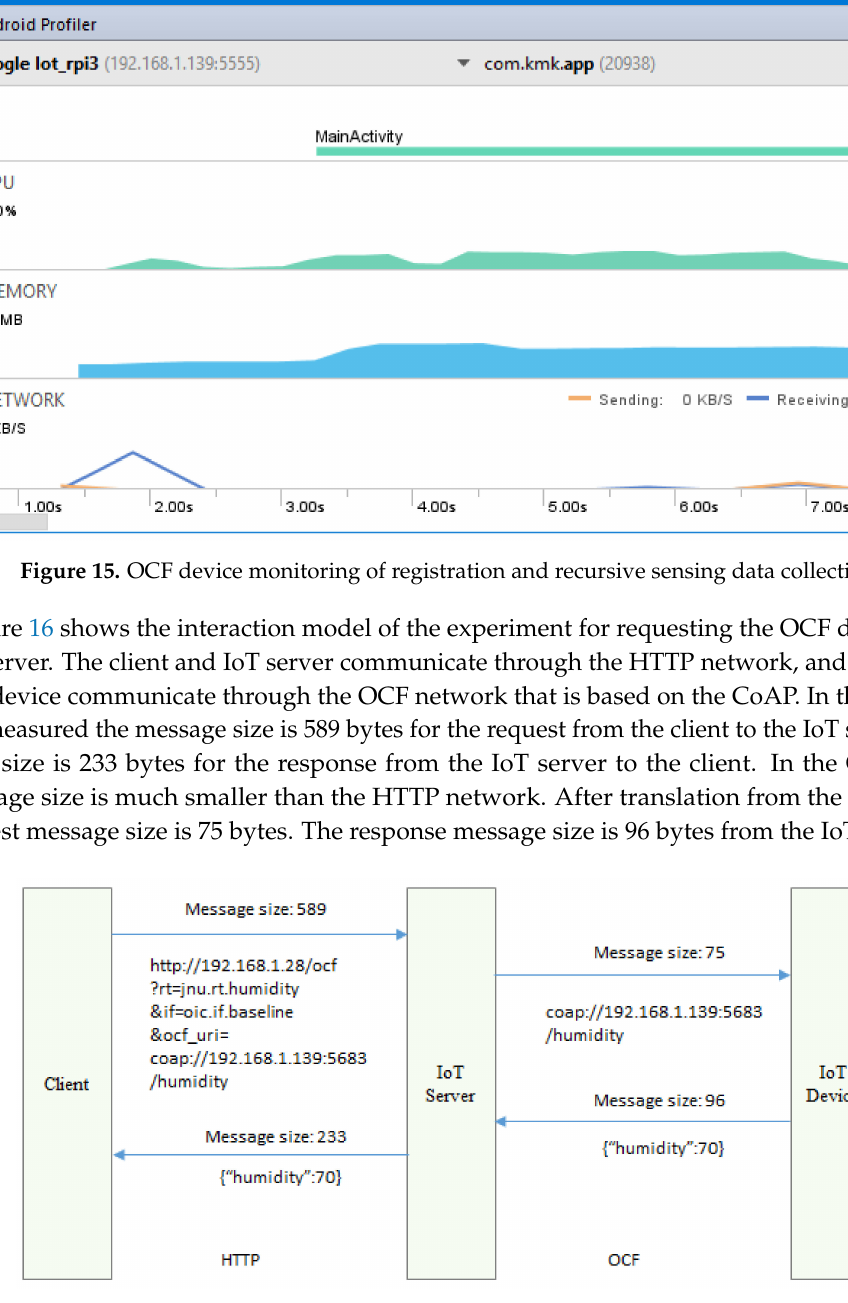
Figure 16. Interaction model for requesting an OCF device through the IoT